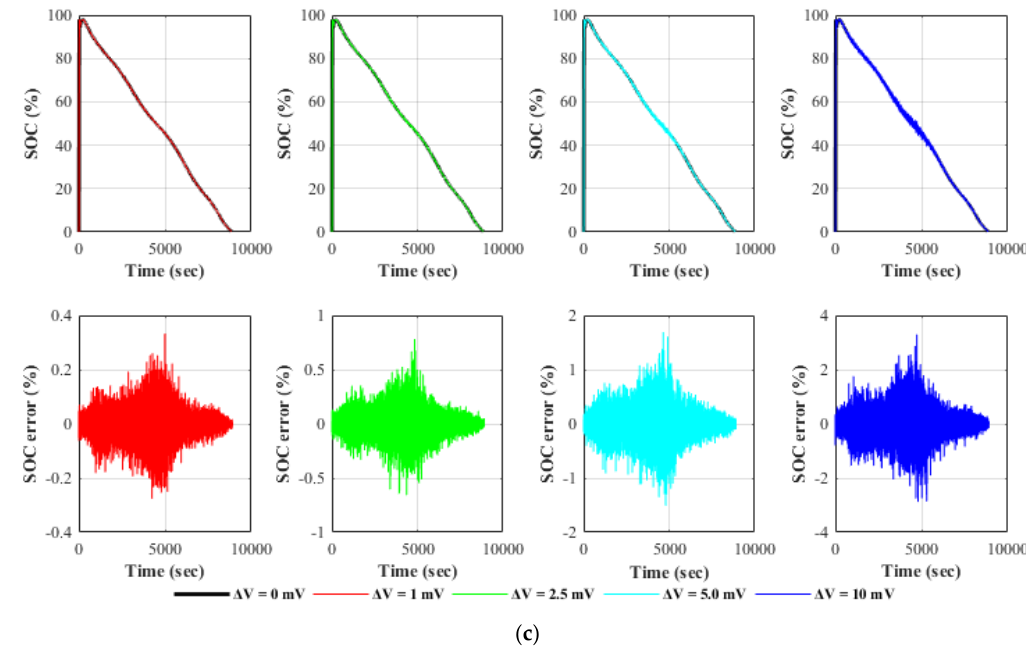
Figure 7. Estimated values at different precision of voltage sensors: ( a ) model parameters; ( b ) estimated OCV; ( c ) estimated SOC.